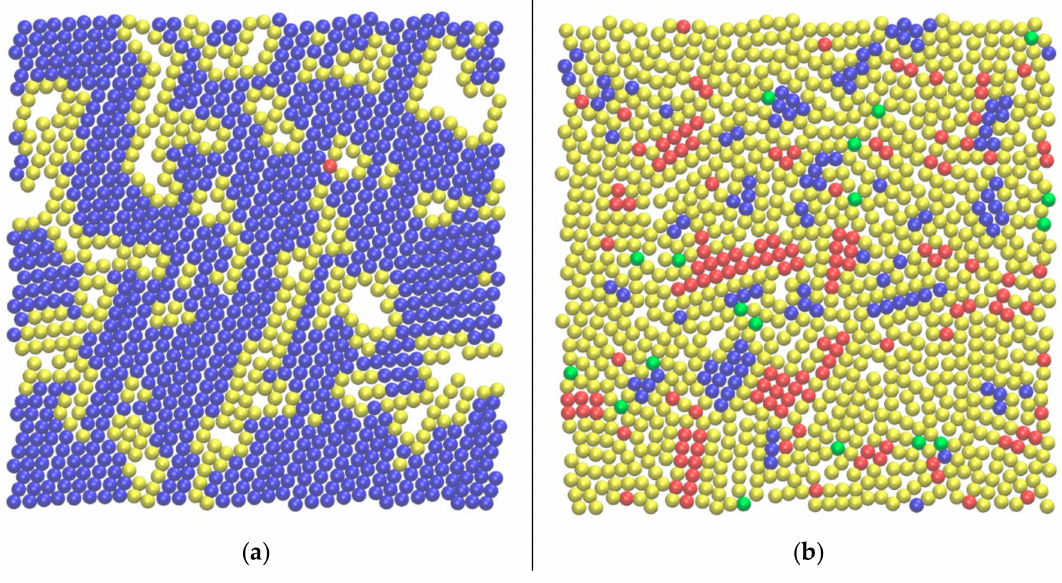
Figure 12. Snapshots of MC simulations on thin films of 100 chains ( N av = 12). Spheres interact with the SW potential. Confinement is applied on the short dimension and periodic boundary conditions on the long ones. ( a ) ε = 0.5 and σ 2 = 1.3. ( b ) ε = 0.5 and σ 2 = 1.6. Spheres are color-coded according to the X -crystal similarity ( ε X < ε thres = 0.245) as identified by the value of the CCE norm. Blue, red, green and cyan colors correspond to TRI, SQU, PEN and HON symmetries, respectively. Amorphous (or “none of the above”) sites are shown in yellow color. Image created with the VMD software. Each figure panel is also available as stand-alone image in 3-D, interactive format in the Supplementary